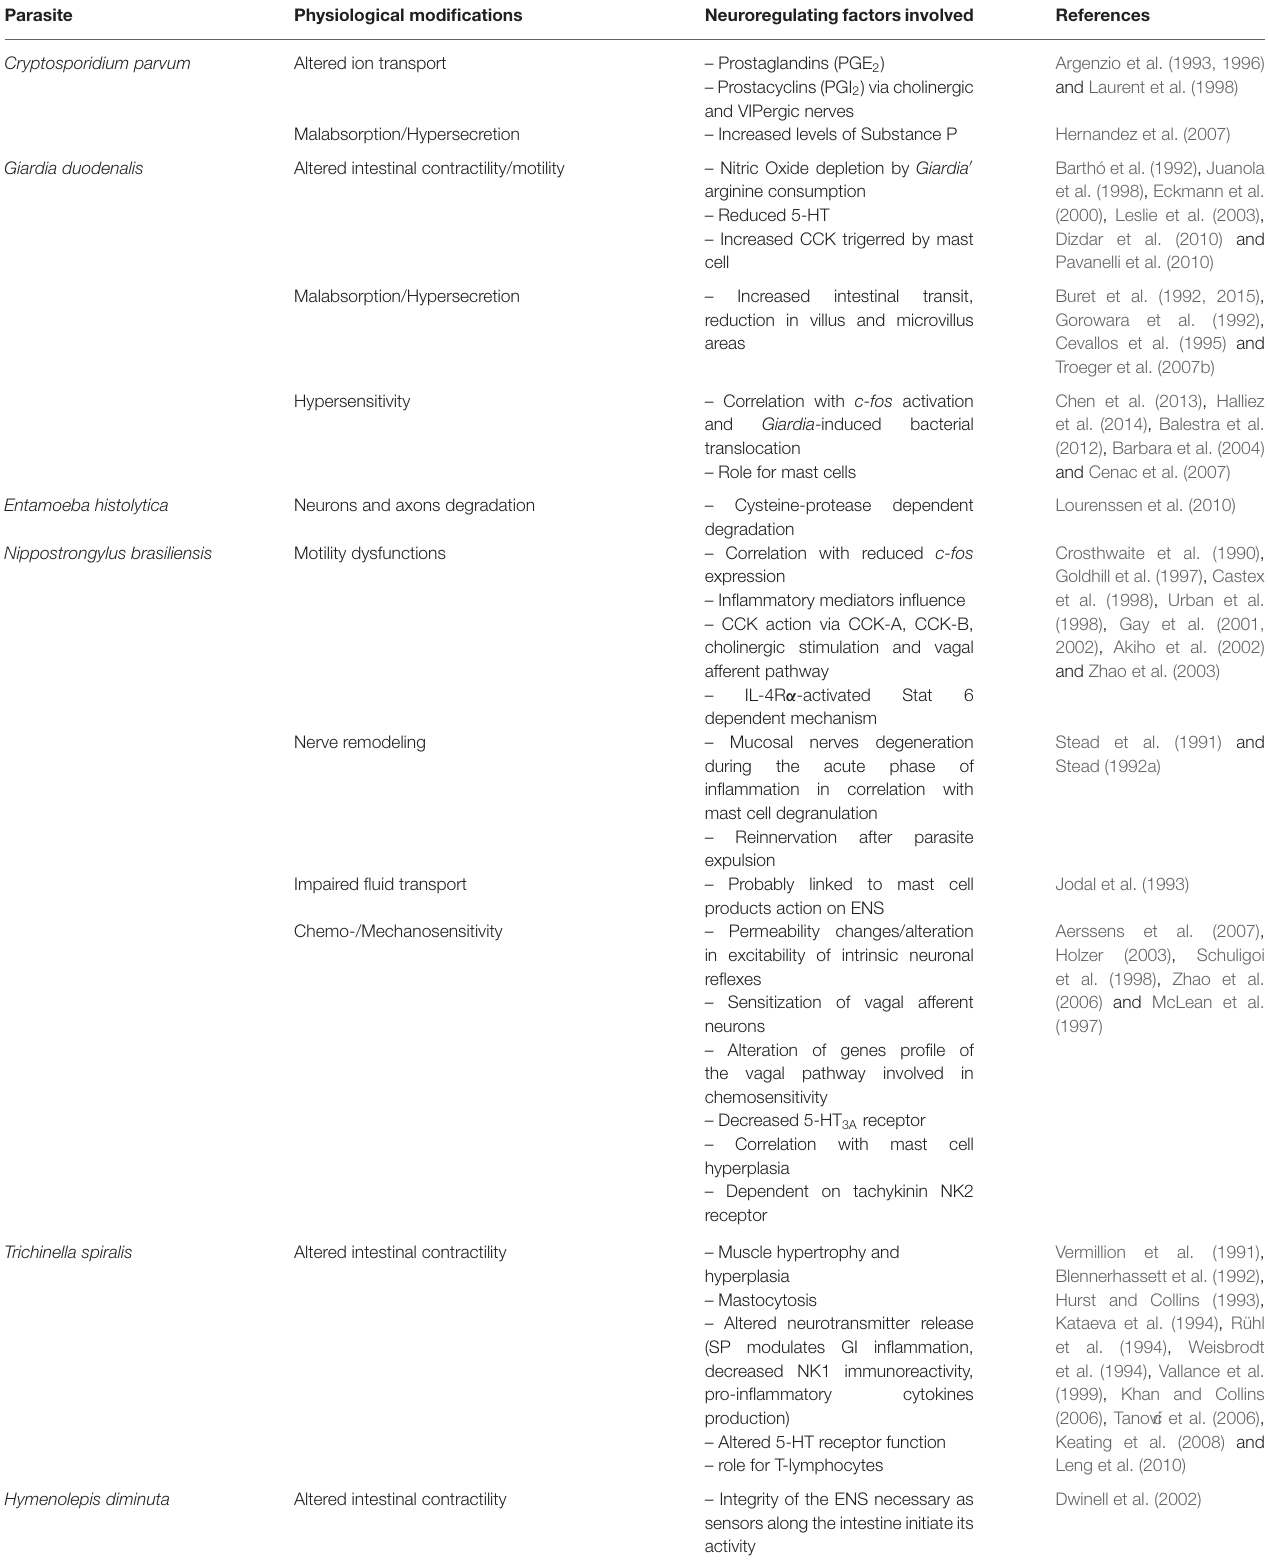
TABLE 1 | This table provides an update on how enteric parasites may alter neuro-regulation pathway in the gut, and lists the physiological consequences that have been associated with these changes